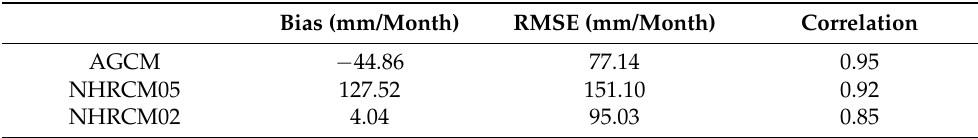
Table 5. Same as in Table 3 but for quantitative evaluation of seasonal changes of 20-year mean monthly precipitation in three simulations against observations. See Figure 5 for seasonal changes.